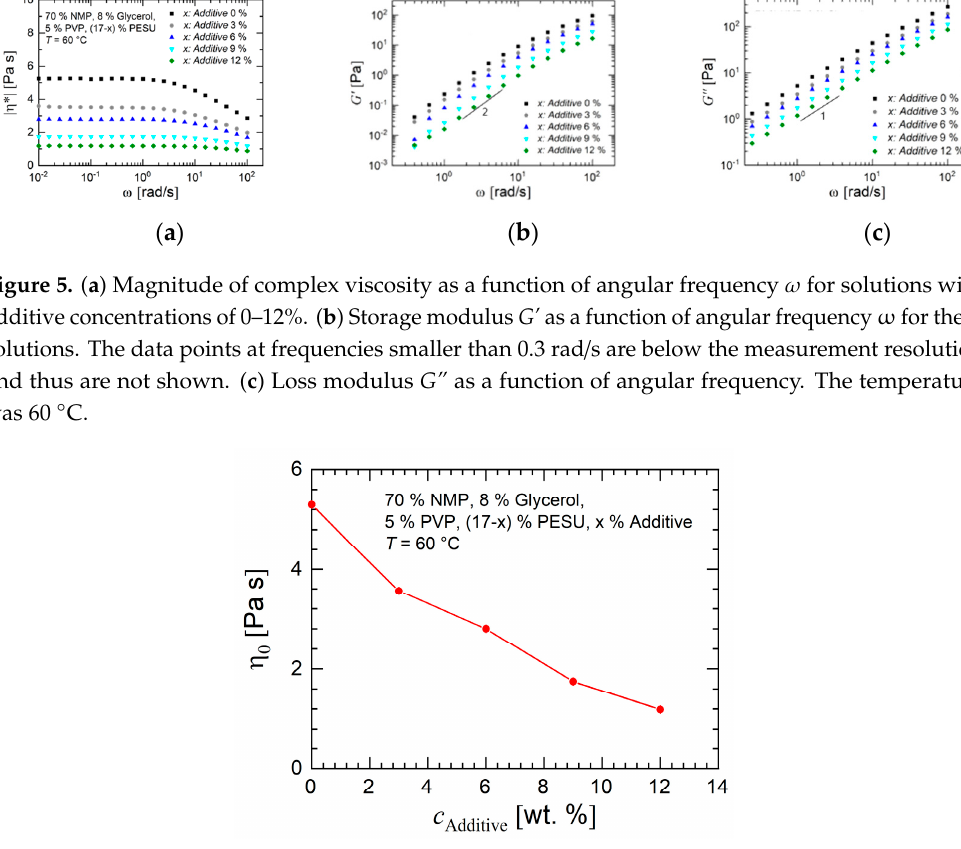
Figure 6. Zero shear rate viscosity η 0 as a function of additive concentration in solution at a temperature of 60 °C.